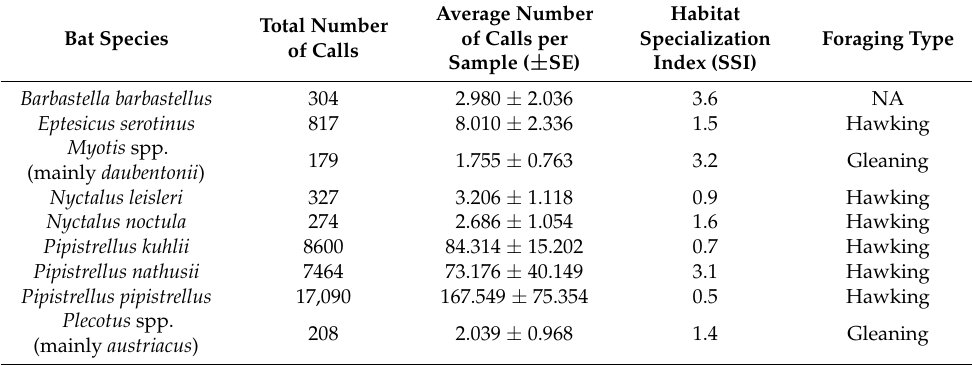
Table 1. Species traits (habitat specialization), foraging strategies and occurrence in samples. For assessment of Habitat Specialization Index, see [59]. We distinguished two main guilds according to their foraging strategies: “gleaning bats” which mainly eat diurnal brachyceran Diptera and non-volant arthropods, such as weevils, lepidopteran larvae, harvestmen and spiders and “hawking bats” which mainly search the sky for